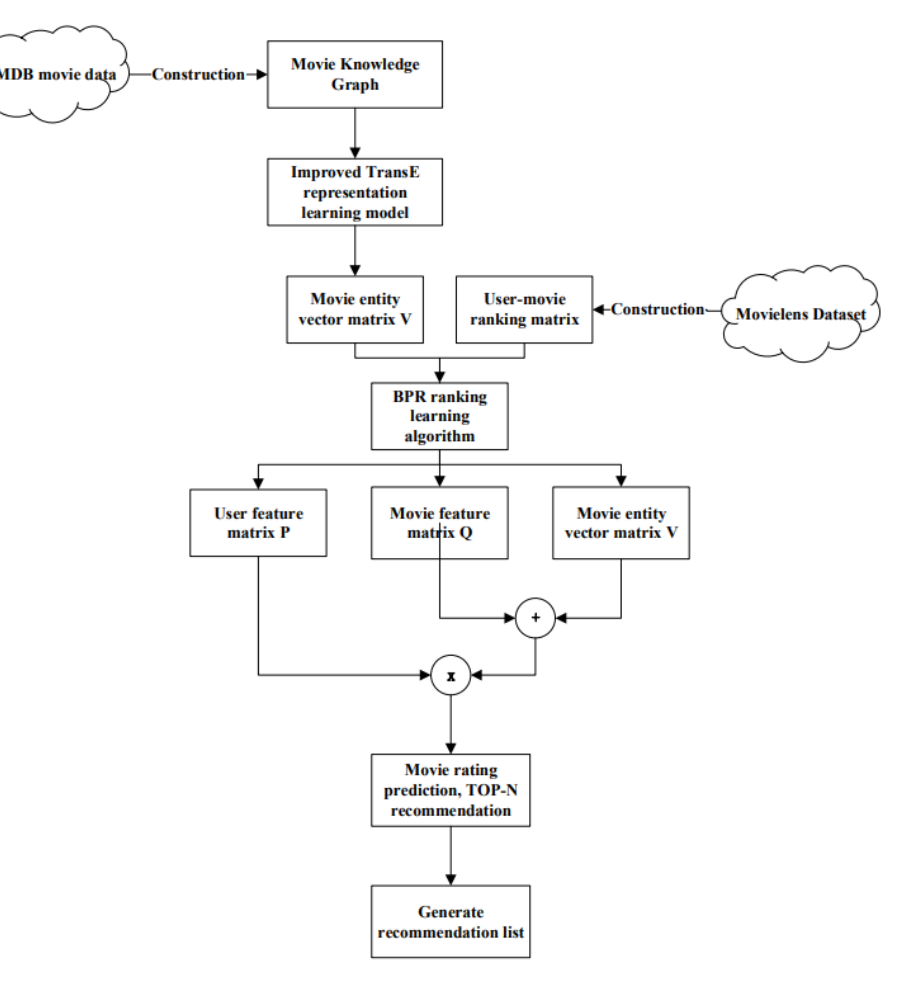
Figure 9. KG-BPR model recommendation